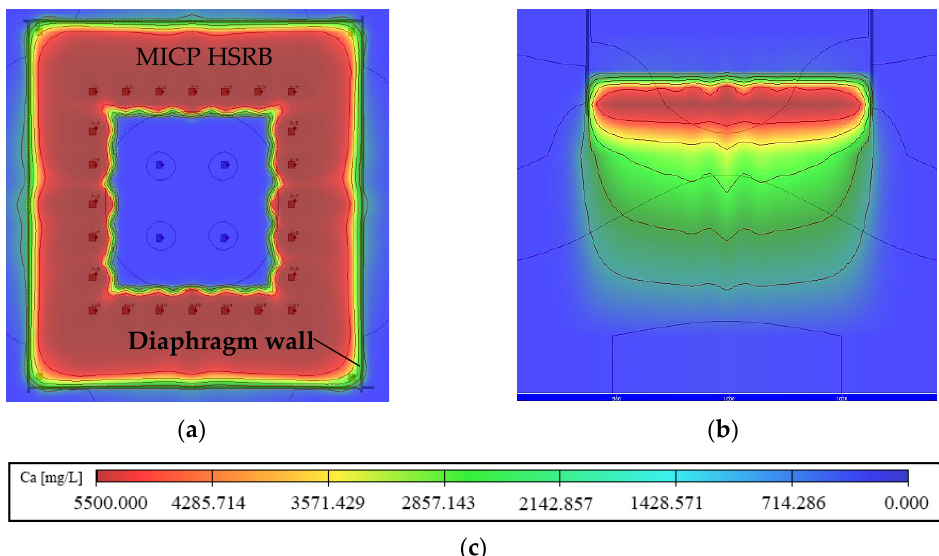
Figure 24. Migration diagram of cementation solution: ( a ) Horizontal; ( b ) Vertical; ( c ) Legend.